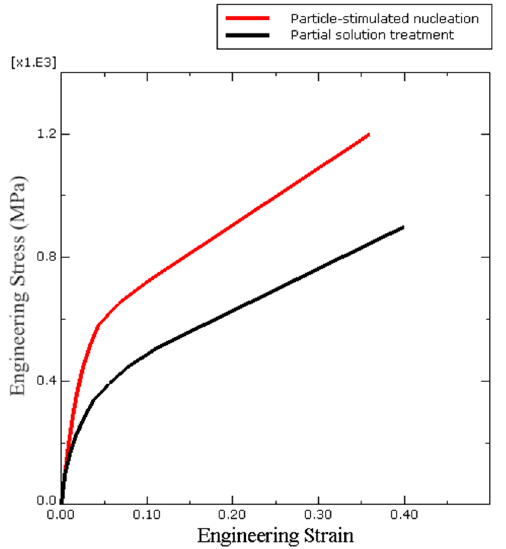
Figure 5. Engineering stress–strain curves of specimens after partial solution treatment (black curve) and particle-stimulated nucleation of recrystallization (red curve) at 850 °C for 30 min.